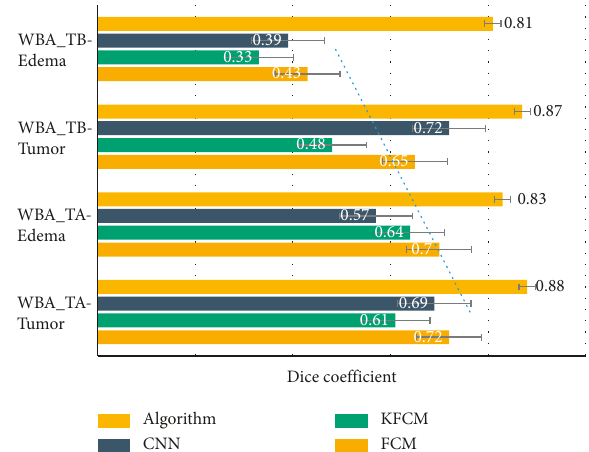
Figure 4: The mean value of the dice coefficient measurement of each segmentation algorithm.